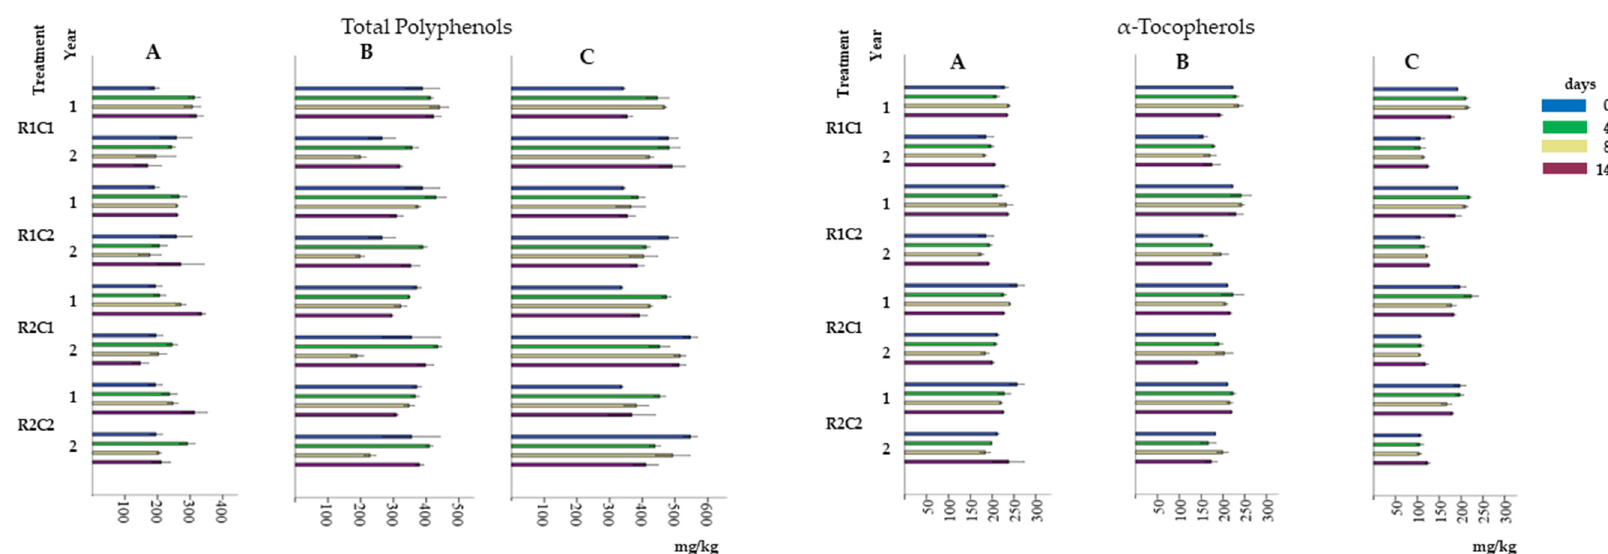
Figure 3. Total polyphenols (mg/kg) and α -tocopherols (mg/kg), noted in the ‘Arbequina’ ( A ), ‘Picual’ ( B ), and ‘Verdial’ ( C ) olive oils extracted from fruit, picked with a Manual Inverted Umbrella (R1) and in a traditional way (R2) and stored for different days at 5 °C (C1) and ambient temperature (C2) during two consecutive years (year 1 and 2). Each bar is the mean ± SD of 3 replicates.